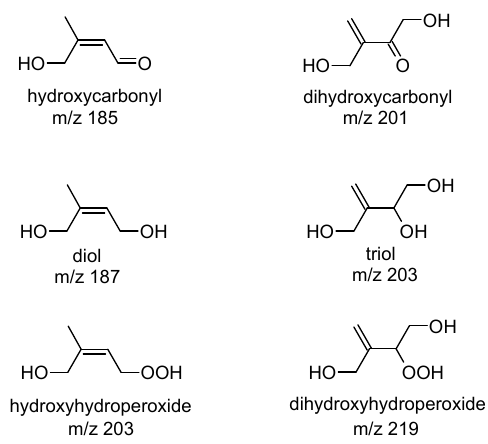
Fig. 5. Products detected by CIMS that may result from the OH- Fig.5. ProductsdetectedbyCIMSthatmayresultfromtheOH-initiatedoxidationofisoprene. Otherisomers arepossible. initiated oxidation of isoprene. Other isomers are